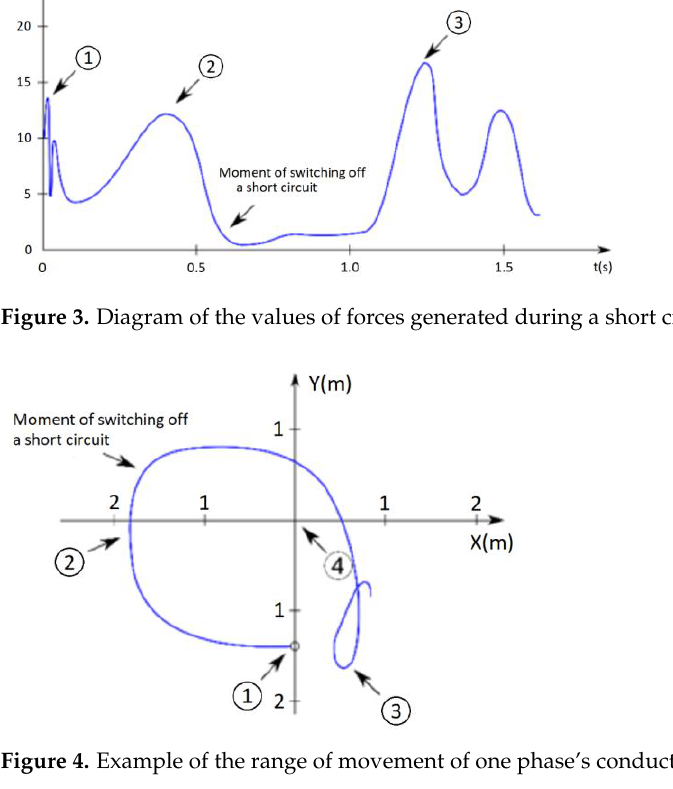
( b ) Figure 5. Static tension: ( a ) Graph of beam force and displacement values of the support structures [5], ( b ) Tie wires before and during a short circuit [6]. The pinch force depends primarily on the geometric dimensions of the bundle, for which the spacers are responsible. Specifically, the bundle force depends on the number of spacers, their type, and also their dimensions. This force is approximately proportional to the distance between the wires. The wires in the bundles must be installed so that they are relatively close to each other. This distance, however, cannot be too small because it will have negative consequences. Among other things, there may be a higher transfer possibility of contacting certain wires to others during normal operating conditions, which could consequently have a reduction in the load capacity of the entire bundle. One can also imagine that in winter, there can be a situation in which the wires stick together when icing occurs. In the highest voltage switchgear, the distance between the wires in